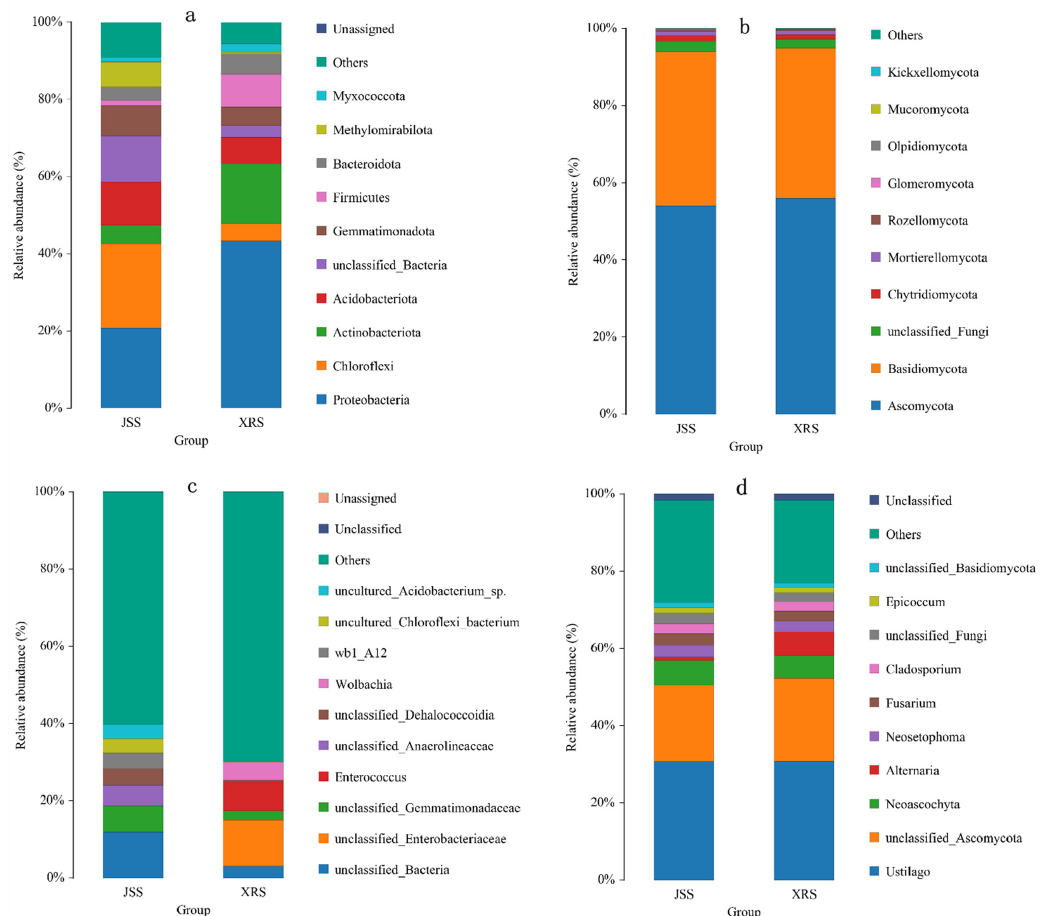
Figure 2. Microbial community structure of different groups. Different colors means different phylum or genus. And different community structure of JSS and XRS were shown above. Bacterial community composition at the phylum ( a ) and genus level ( c ); fungal community composition at the phylum ( b ) and genus level ( d ). JSS: the bulk soil sample; XRS: soil of the P. sibiricum rhizosphere.